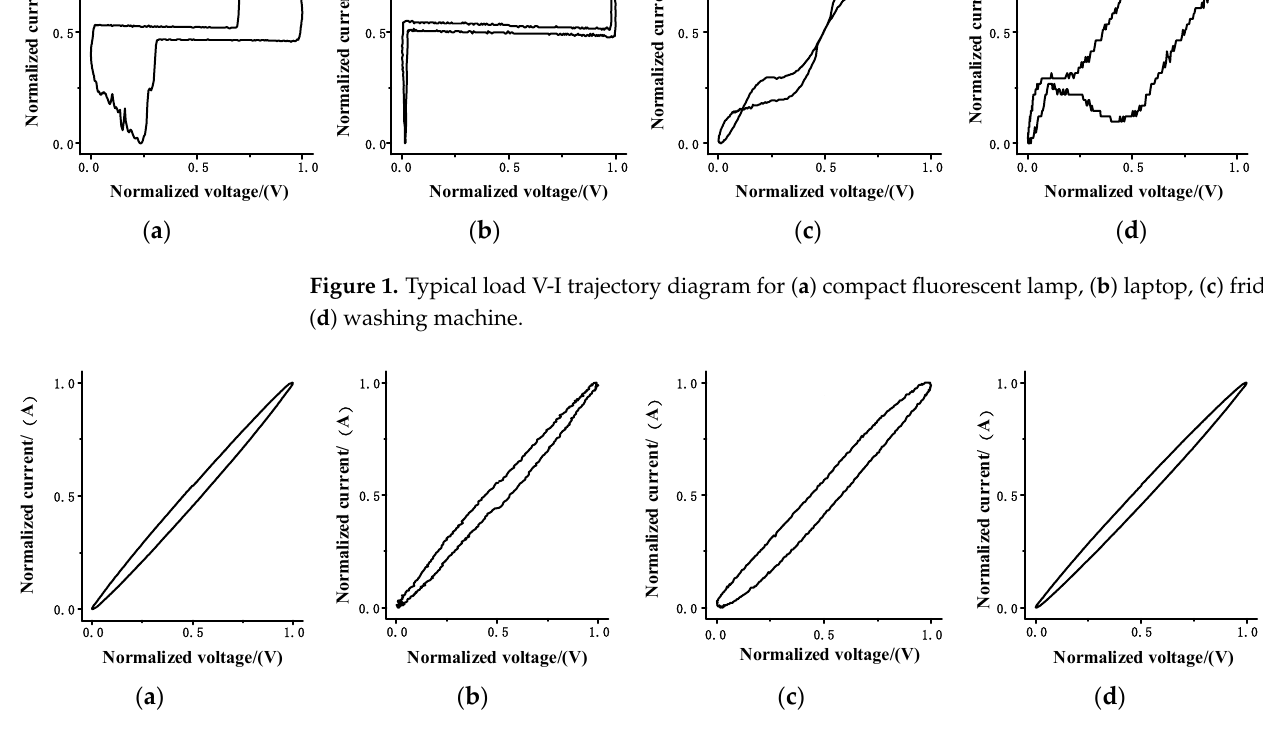
Figure 1. Typical load V-I trajectory diagram for ( a ) compact fl uorescent lamp, ( b ) laptop, ( c ) fridge, ( d ) washing machine.